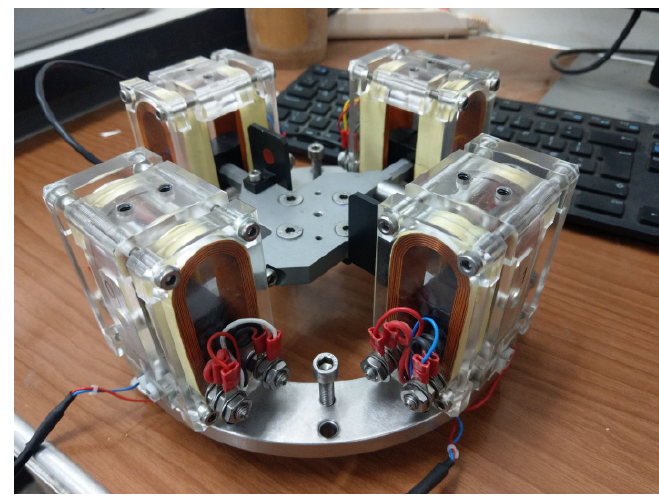
Figure 2. Resonant column magnetic drive system.